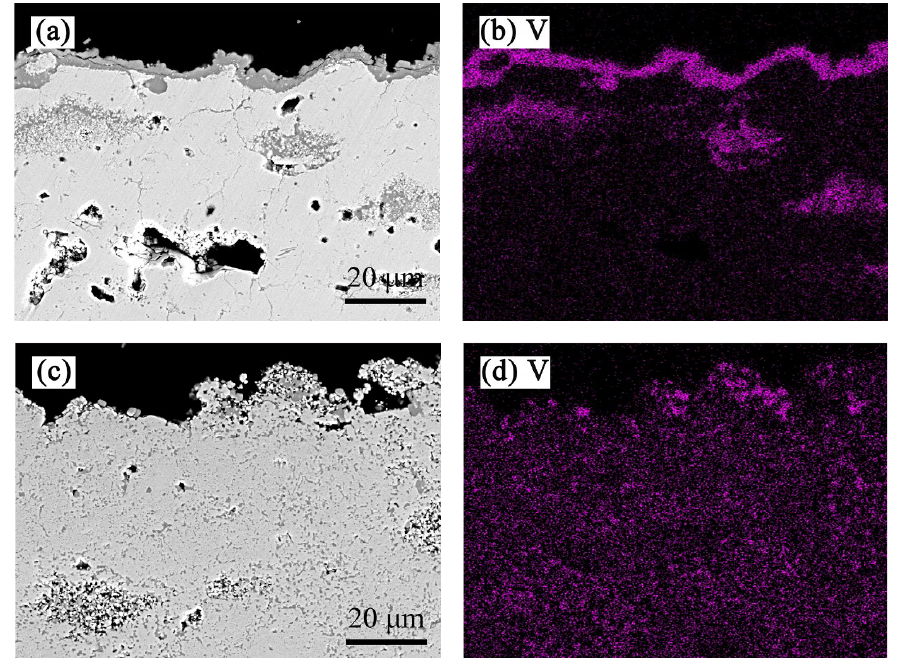
Fig. 7 Cross-sectional images of the as-sprayed YSZ coatings after hot corrosion at (a) 700 ℃ and (c) 1000 ℃ . Figures (b) and (d) display the corresponding V distribution of figures (a) and (c), respectively.